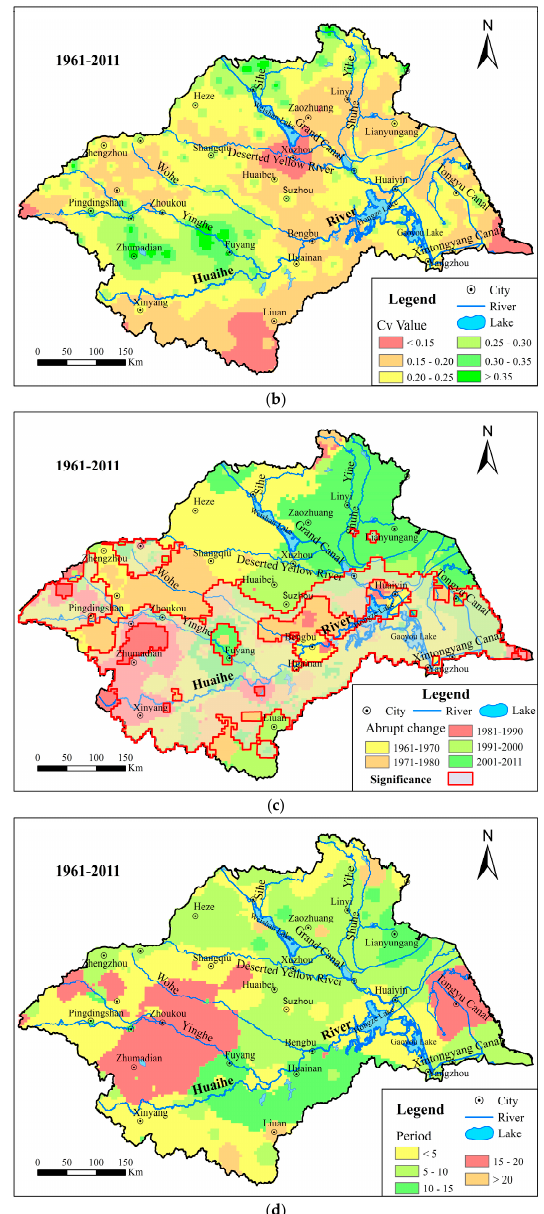
Figure 3. Spatital distribution for trend ( a ); randomicity ( b ); abrupt change ( c ) and periodicity ( d ) of annual precipitation during 1961 to 2011 in the Huaihe River basin.